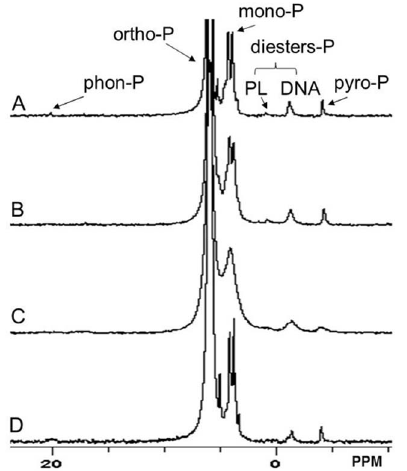
Figure 3. 31 P-NMR spectra for different extracts of the river sediments (A: 0.5 M NaOH and 100 mM EDTA; B: 0.25 M NaOH and 50 mM EDTA; C: 0.25 M NaOH; D: 1 M NaOH and 50 mM EDTA).